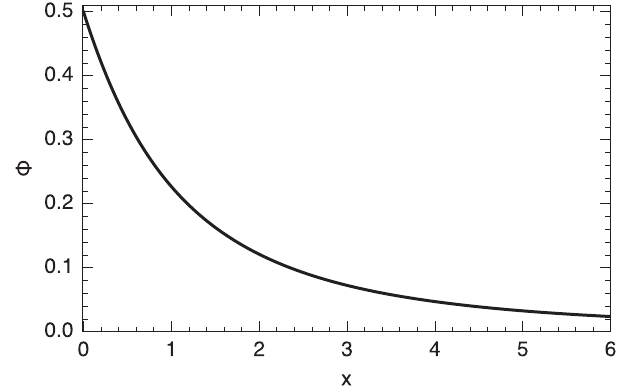
FIG. 2. Function Φ ð x Þ for positive values of the